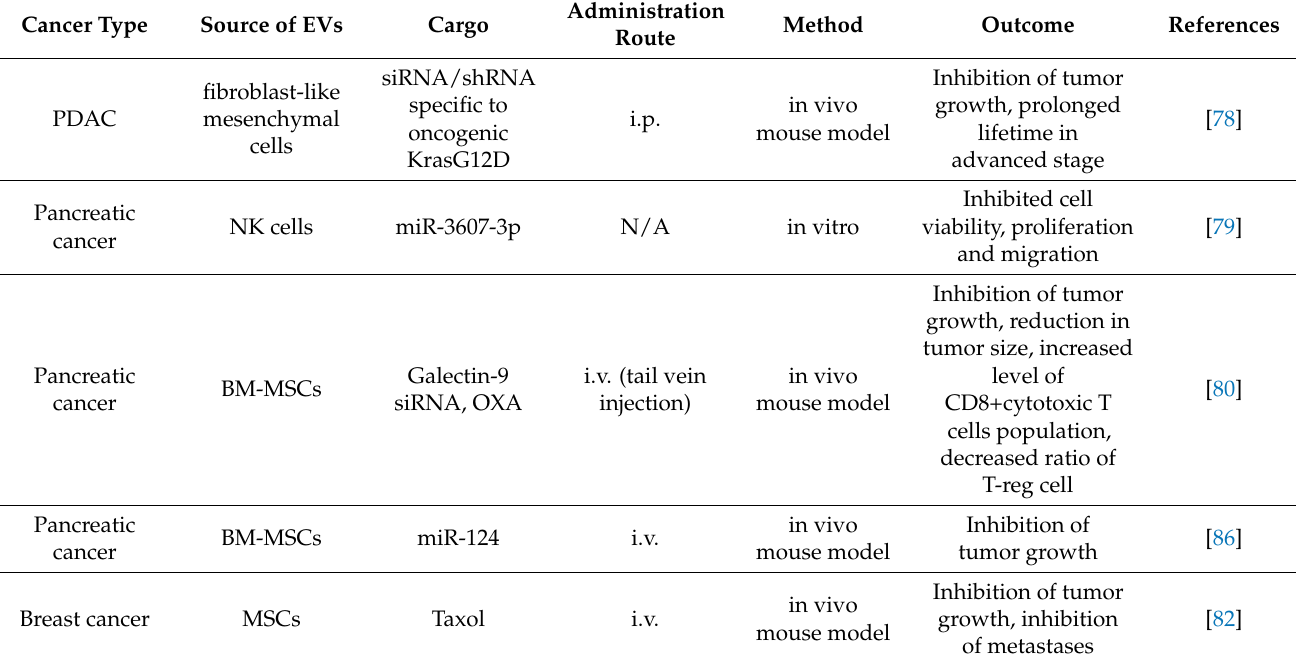
Table 1. EVs in cancer